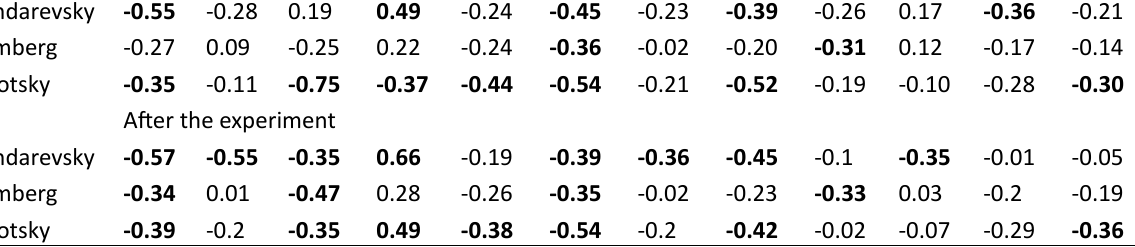
Tests / indicators of game